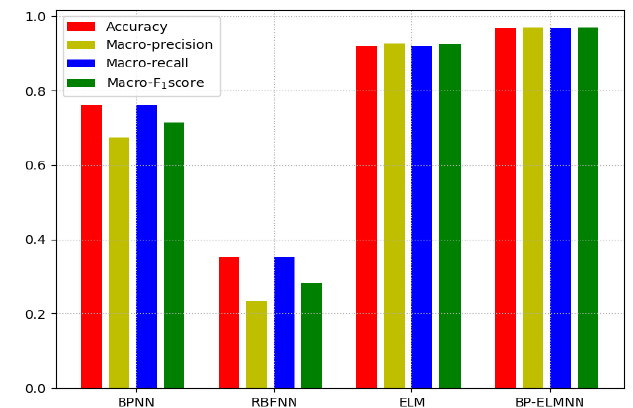
Figure 9. Bar chart of the performance of the four methods (accuracy, macro-precision, macro-recall, and macro-F1 score) for the NTE.